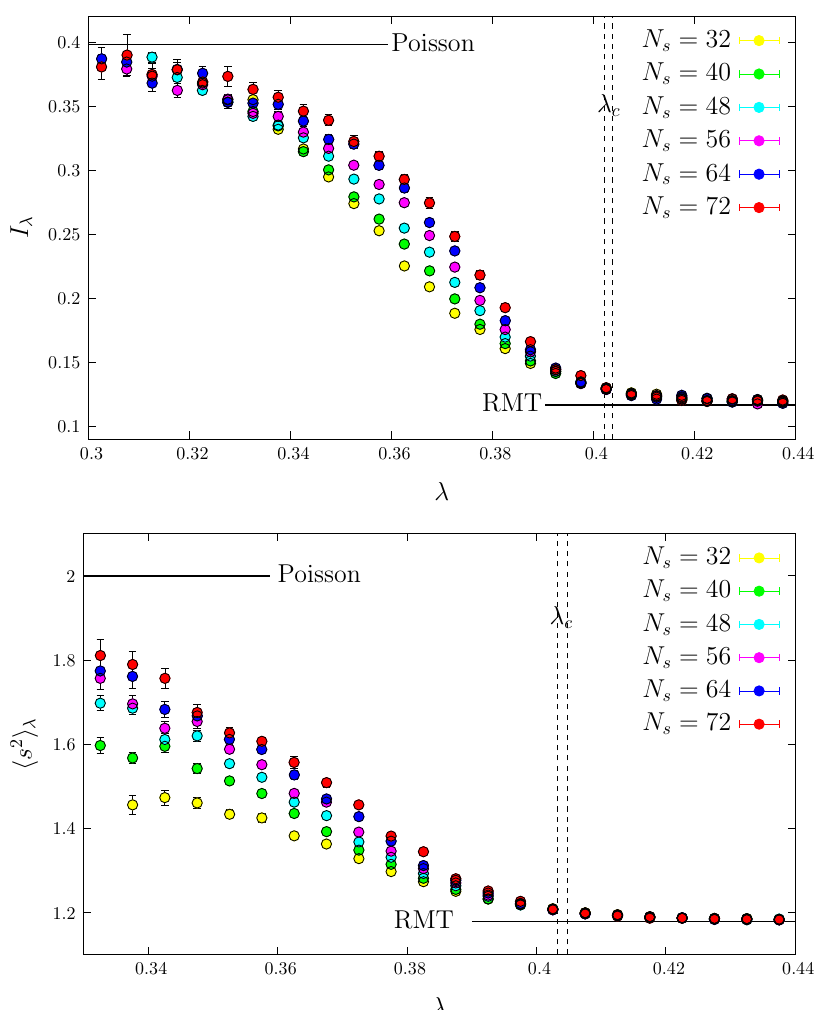
Figure 5 . Dependence on the spectral region for I λ (top) and phase at ¯ β = 6 . 25 for several volumes. Only points with the mobility edge and its uncertainty, as determined via a finite-size scaling analysis, are also